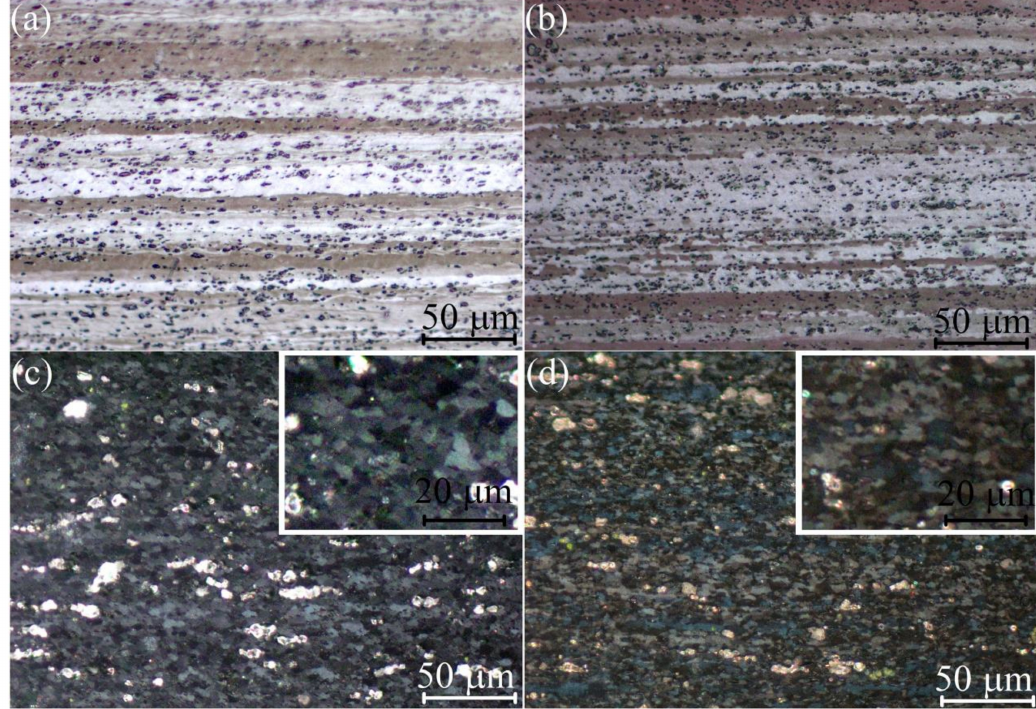
Figure 2. Grain structure of the investigated Al-Mg-Fe-Ni-Zr-Sc alloy ( a , b ) before the start of the superplastic deformation at ( a ) 420 ◦ C, ( b ) 540 ◦ C, and ( c , d ) after the superplastic deformation (logarithmic strain of 1.5) at a temperature of 460 ◦ C with strain rates of ( c ) 0.008 and ( d ) 0.06 s − 1